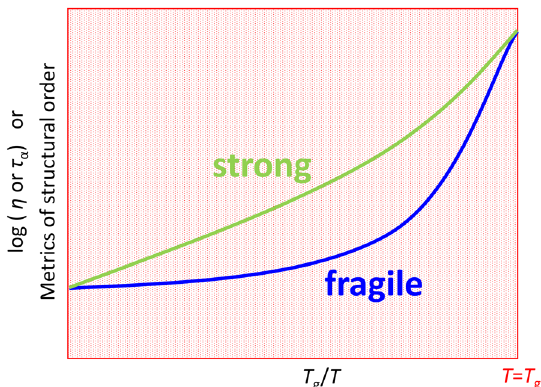
Fig. 2 Schematic description of the strong and fragile liquids using the Angell plot: viscosity ( η ) or α -relaxation time ( τ α ) for y -axis (in logarithmic scale) and normalized temperature ( T / T g ) for x -axis. T g is the glass transition temperature. Schematically, it ’ s also